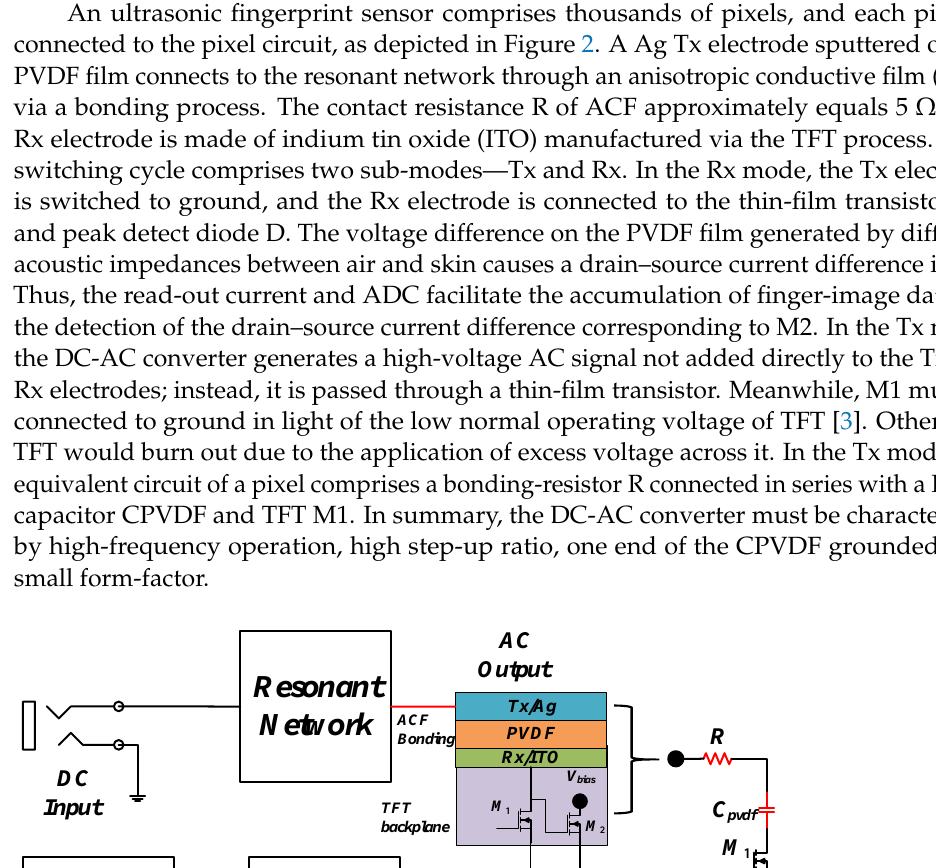
Figure 1. Ultrasonic fingerprint-sensor module.